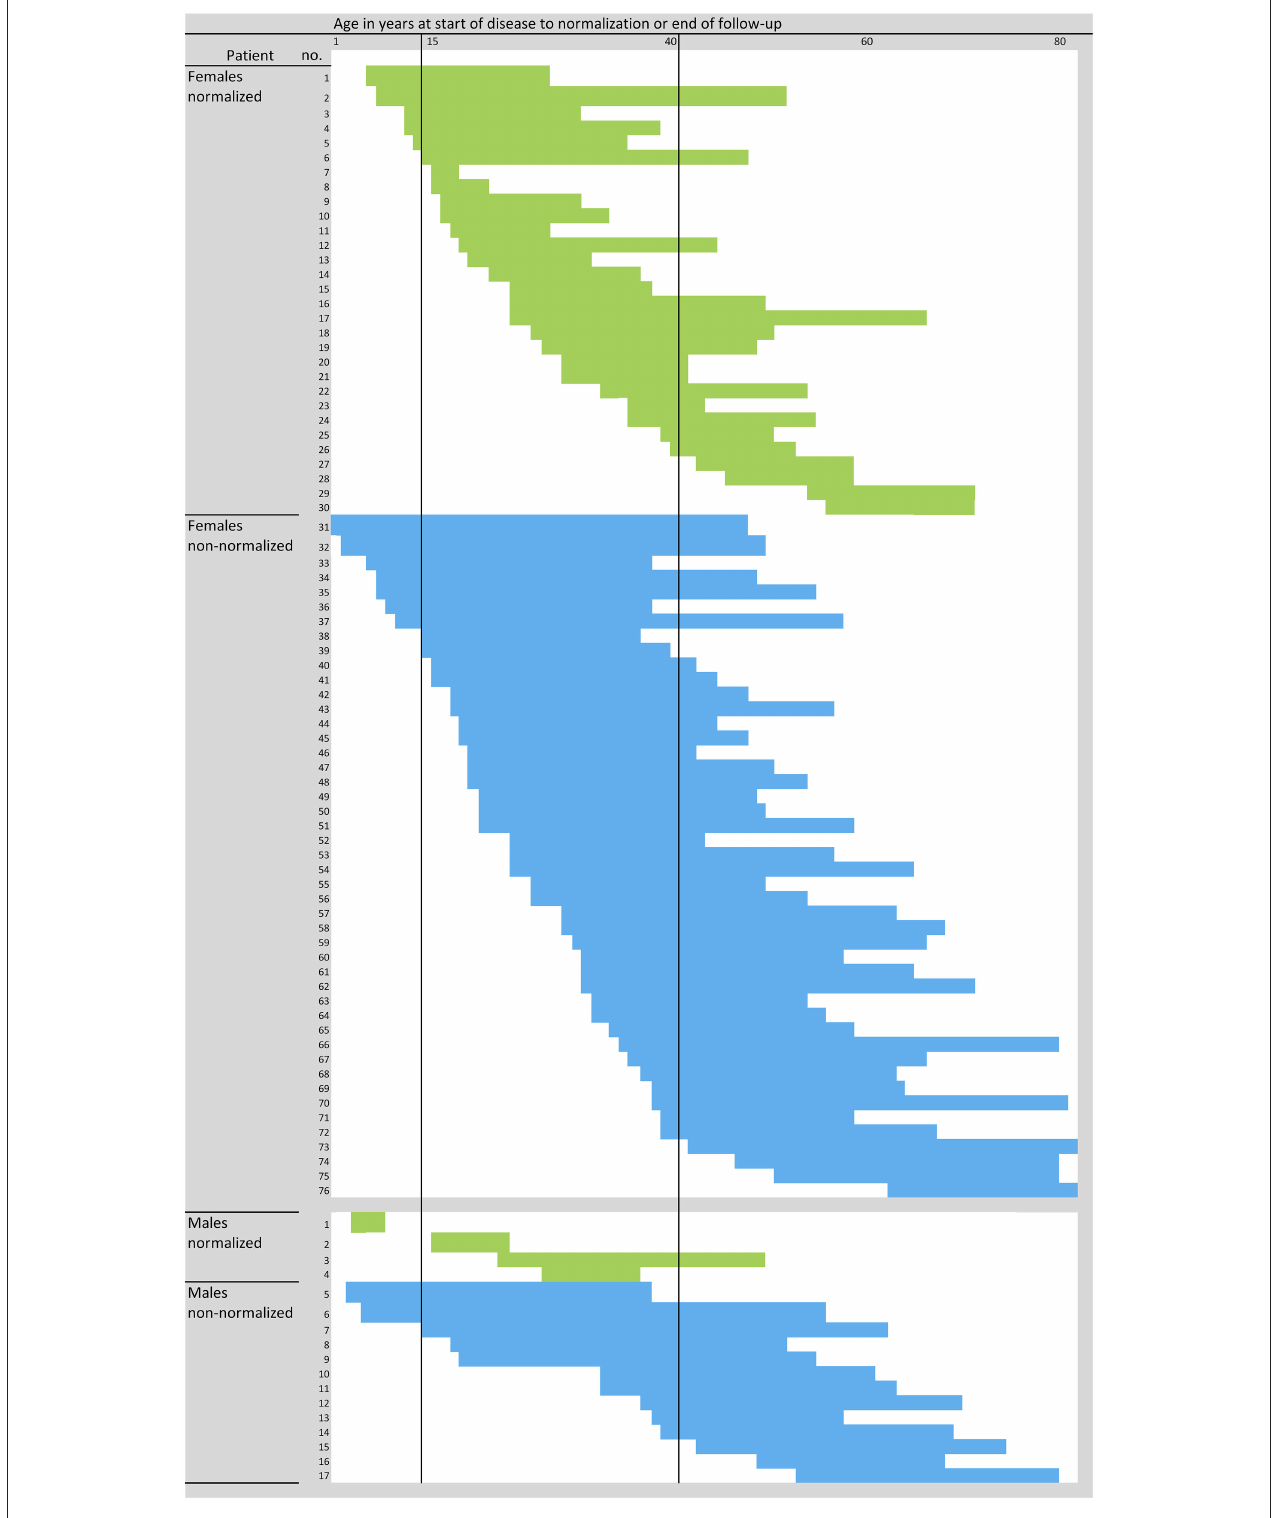
FIGURE 2 | Course of disease in individual PLE patients. Blue and green represent individual patients and their time span from onset of disease to normalization of sun sensitivity (i.e., cessation of PLE symptoms) (green), being considered as event, or the end of the follow-up (not-normalized, blue), being considered as censored. N = 97 patients; three women did not exactly report the start and/or cessation or improvement of symptoms, and one man did not answer the question on the course of the disease at all, and thus the data for these four patients were not plotted.